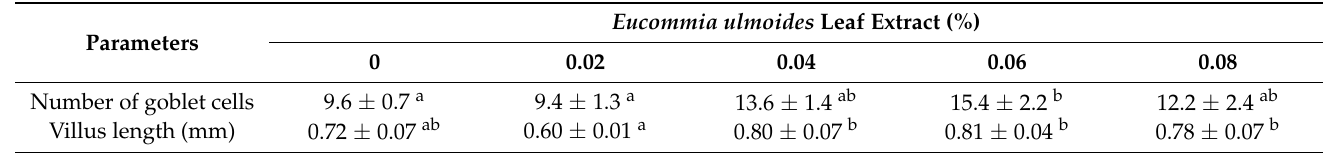
Table 8. The effects of ELE on the intestinal morphology of the